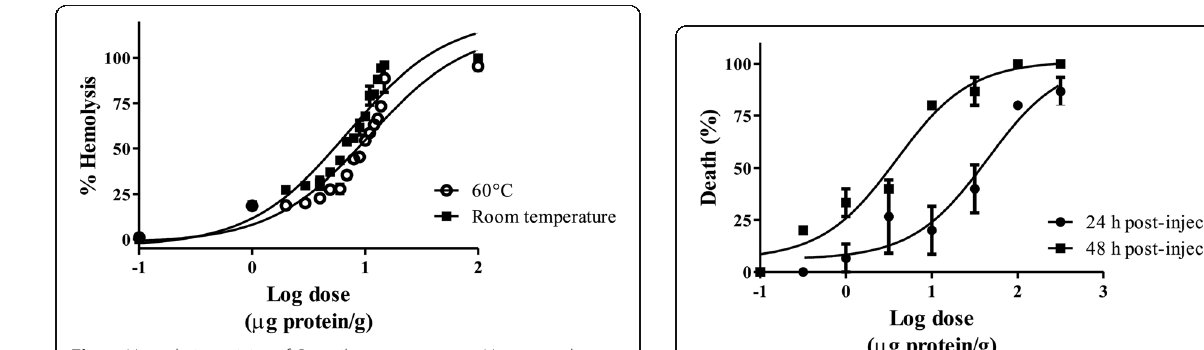
Fig. 1 Hemolytic activity of P. caribaeorum venom. Human red blood cells were incubated for 30 min at 37° and 60 °C. Values are mean S.E.M. of four independent experiments, with triplicate values